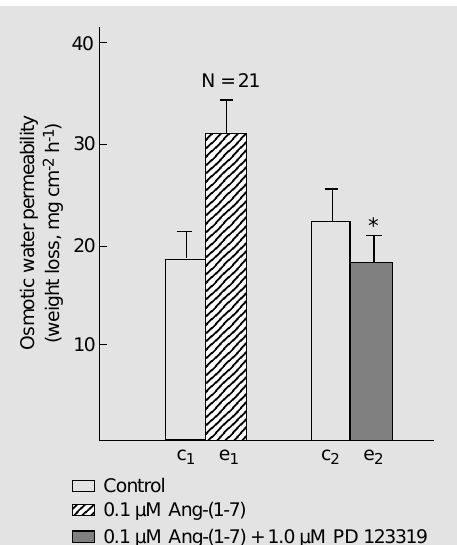
Figure 6 - Inhibition of the re- sponse of toad skin to Ang-(1-7) by the AT 2 receptor antagonist PD 123319. Data are reported as means ± SEM. One-way ANOVA followed by the Newman-Keuls test showed a significant differ- ence (*P<0.01) between the ex- perimental periods e 1 and e 2 . There was no significant differ- ence between c 1 and c 2